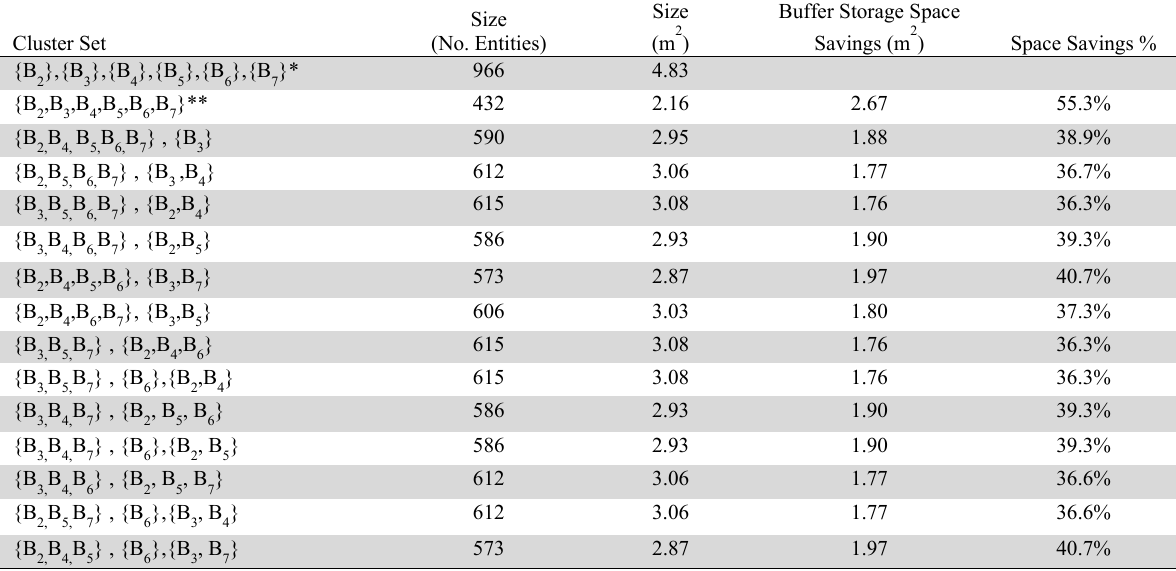
*Dedicated Buffers ** Optimal Buffer Cluster without space